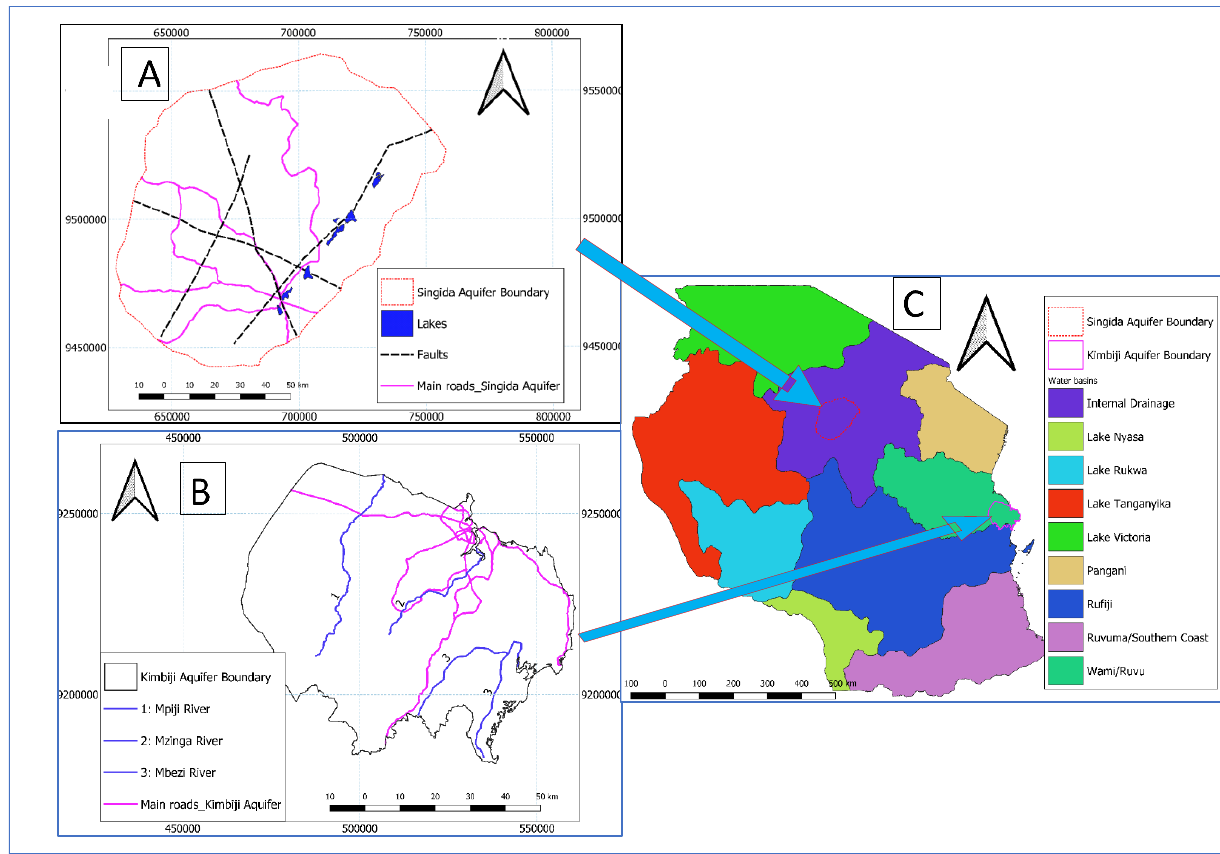
Figure 1. Maps showing the position of the two study areas( A , B ) in relation to the Wami-Ruvu basin and the Country( C ).